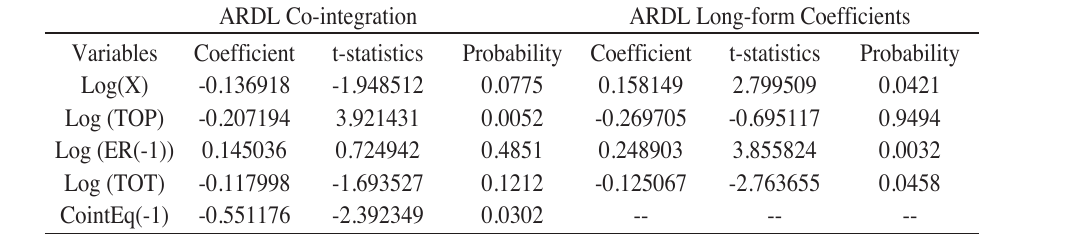
ARDL Co-integrating and Long Run Form